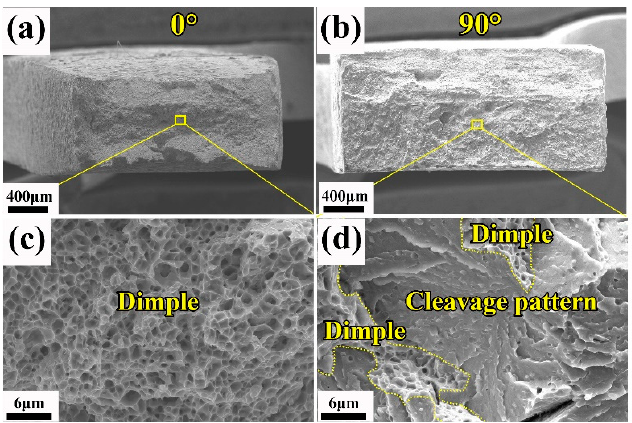
Figure 9. ( a , b ) Images of the fracture surfaces in 0° and 90° samples after the tensile test; ( c , d ) images of the magnified microscopic fracture morphology in 0°and 90° samples.